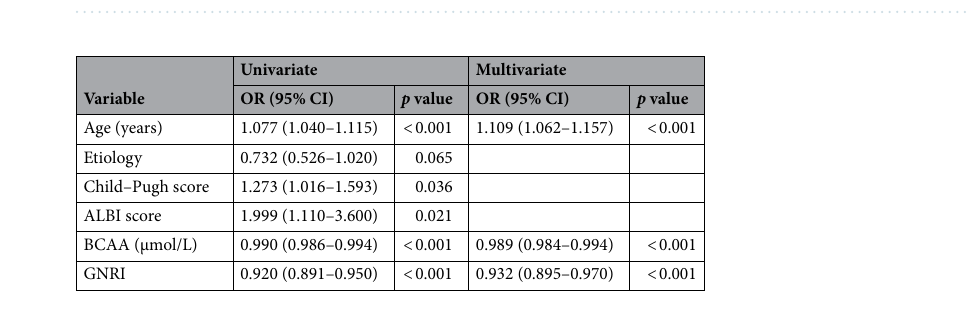
Table 3. Significant factors associated with sarcopenia in patients with liver cirrhosis. ALBI albumin-bilirubin, CI confidence interval, BCAA branched-chain amino acid, GNRI Geriatric Nutritional Risk Index, OR odds